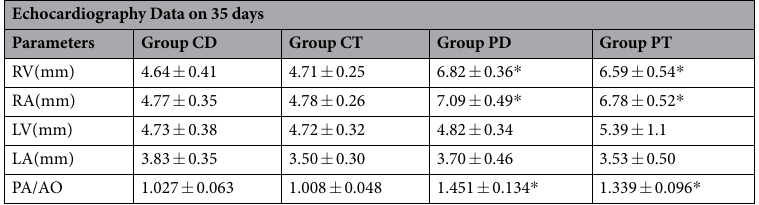
Table 3. Echocardiography examination results of rats in the PAH and control groups with or without LXR activation. n = 6, * Compare with Group CD, p <